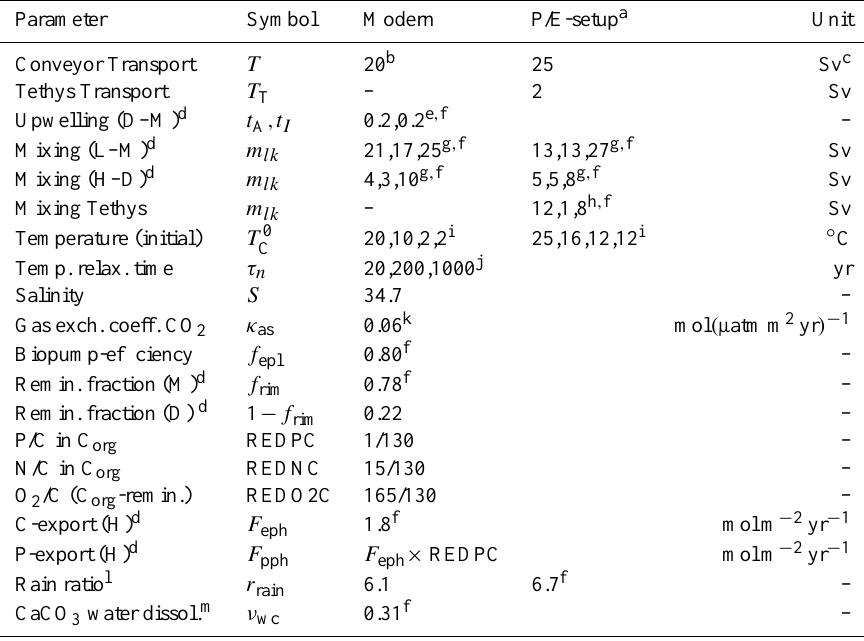
Table 2. Physical and biogeochemical parameters (ocean model).